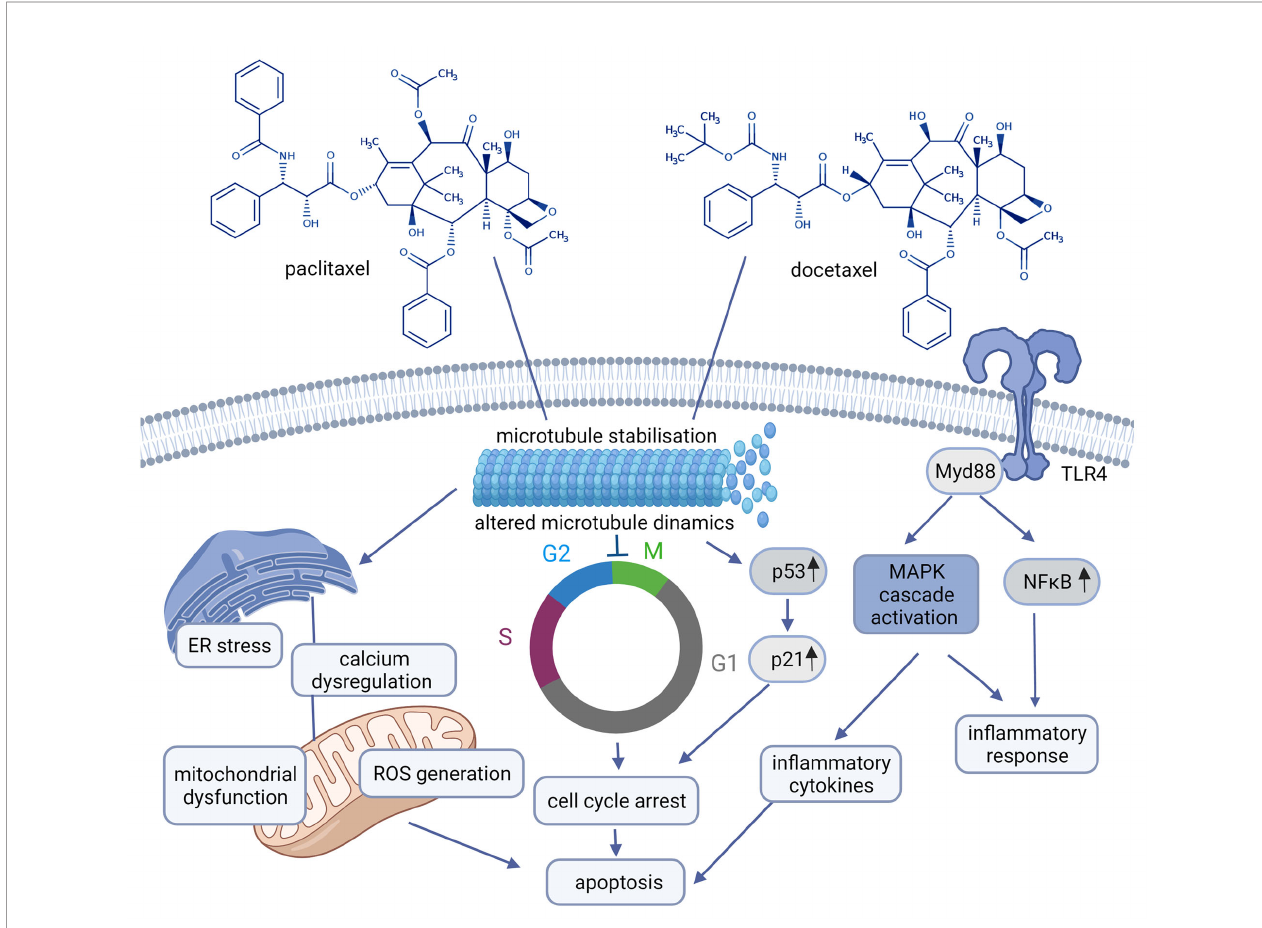
FIGURE 2 | Chemical structures of paclitaxel, docetaxel and their mechanism of action (paclitaxel: CHEBI:45863, docetaxel: CHEBI:4672) Created with BioRender. com. Agreement number: